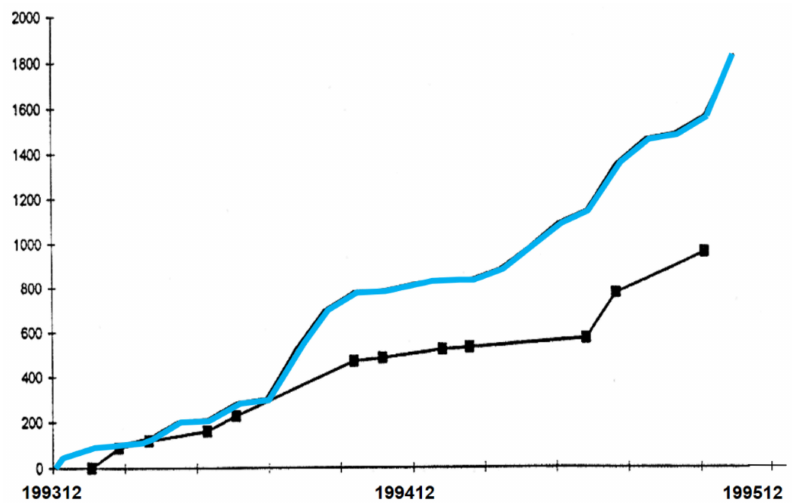
Figure 7. First tentative correlation between the displacement of a point in the lower unit (mm, black line) and the cumulative rainfall (mm, blue line), during 1994–1995.